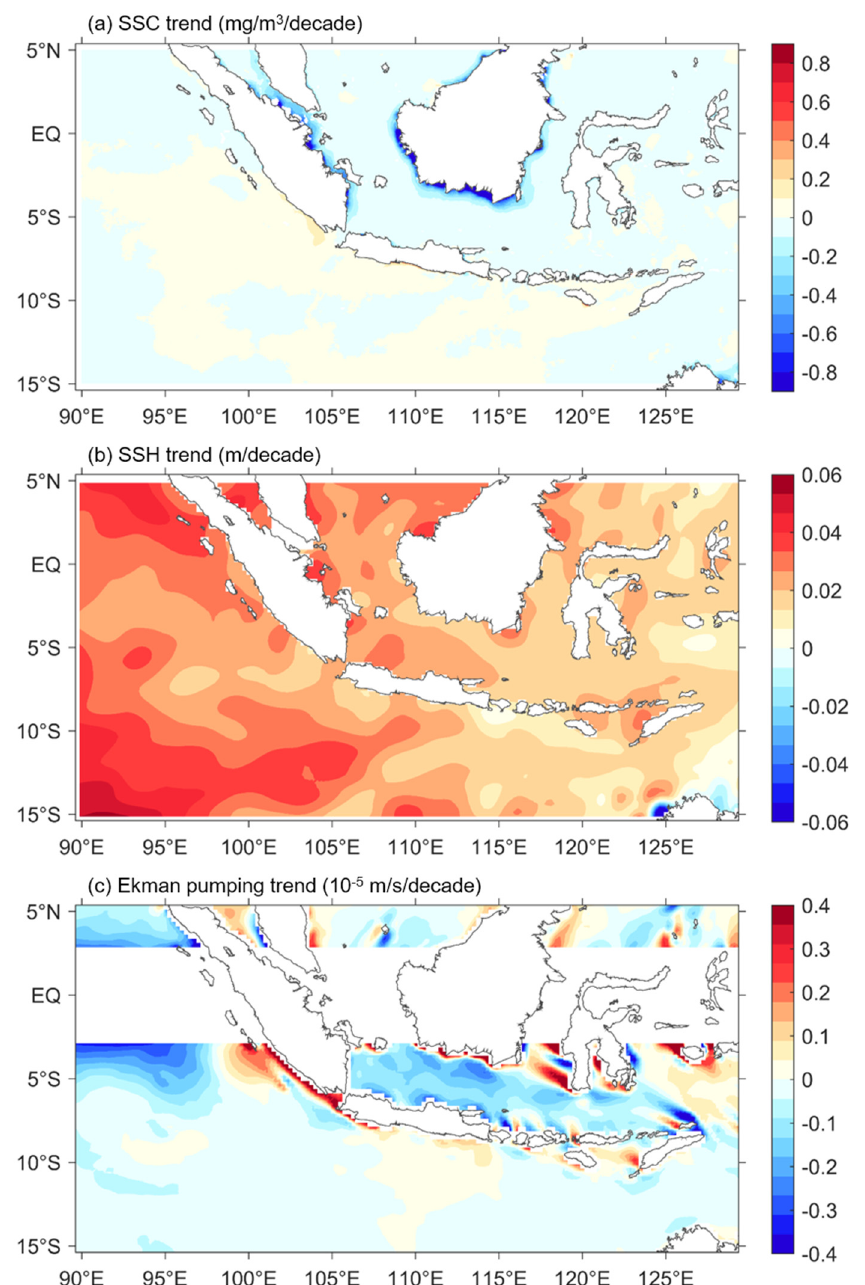
Figure 12. Long-term trend during the period of 1998 to 2019 in ( a ) SSC; ( b ) SSH; and ( c ) Ekman pumping.